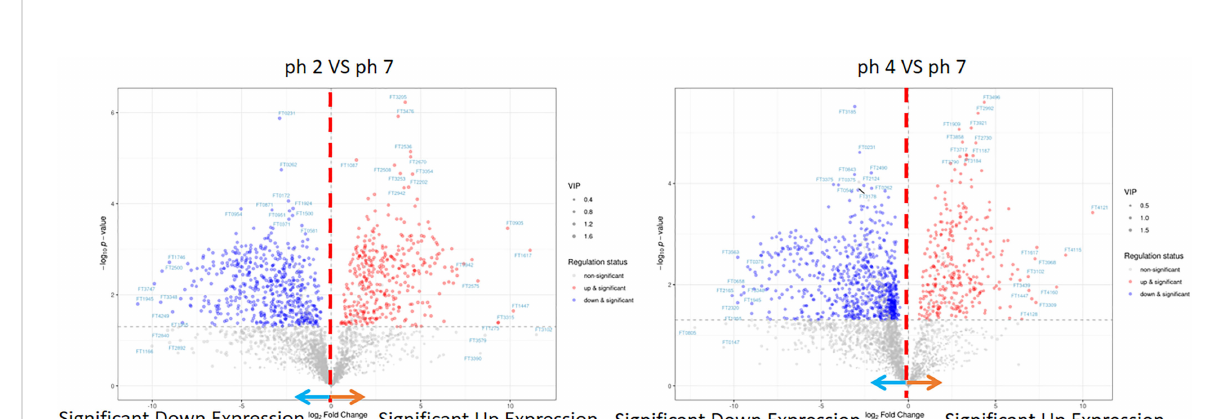
FIGURE 5 LC-MS metabolite of the pH 2 vs. pH 7 and pH 4 vs. pH 7 groups. The pH 2 vs. pH 7 and pH 4 vs. pH 7 groups were considered to be with a fold change ≥ 2 or a fold change.